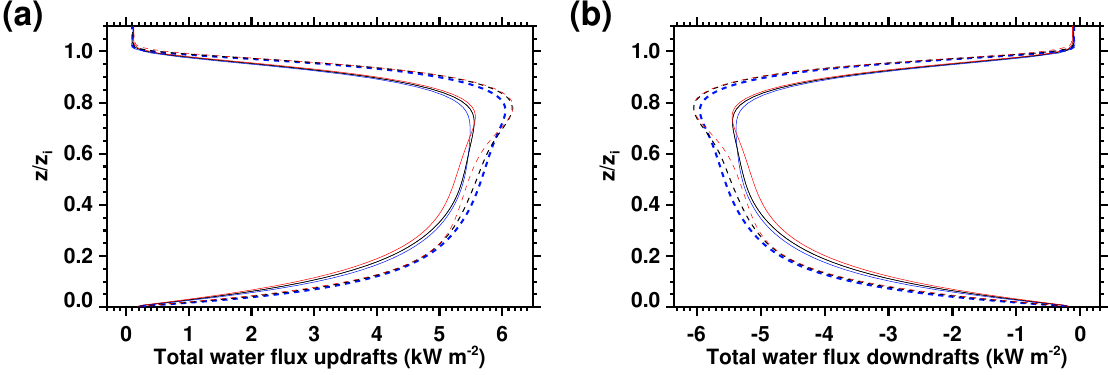
Figure C6. Effect of resolution. Profiles averaged over the period N (10:20–11:20UT) from simulations M − (blue), M 0 (black), M + (red), solid curves, and from simulations M − area of the